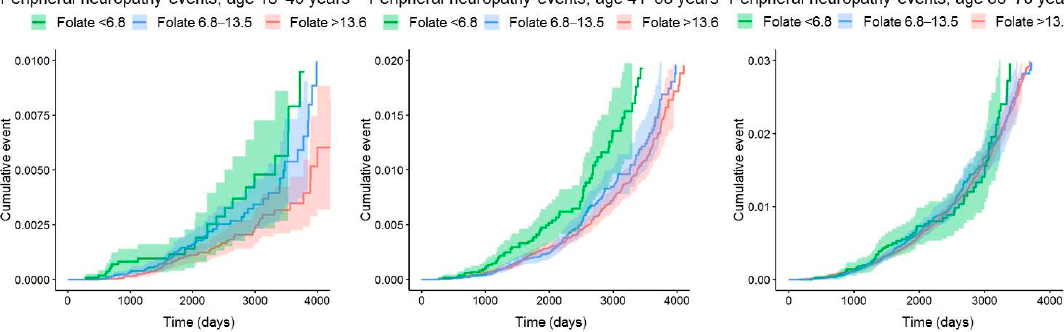
Table 2. Hazard ratios (95% CI (confidence intervals)) of peripheral neuropathy and mortality according to categories of serum folate concentrations and age group. 1